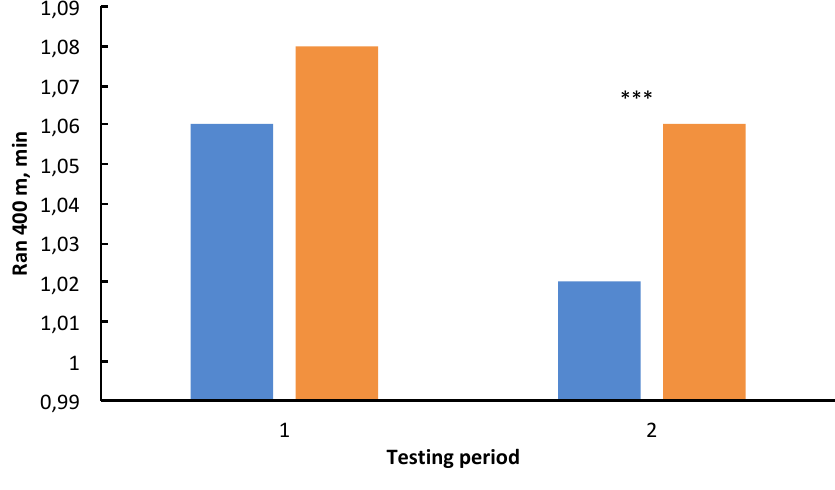
Fig. 1. Results of the test “400 m run” by athletes of the experimental and the control groups before and after the